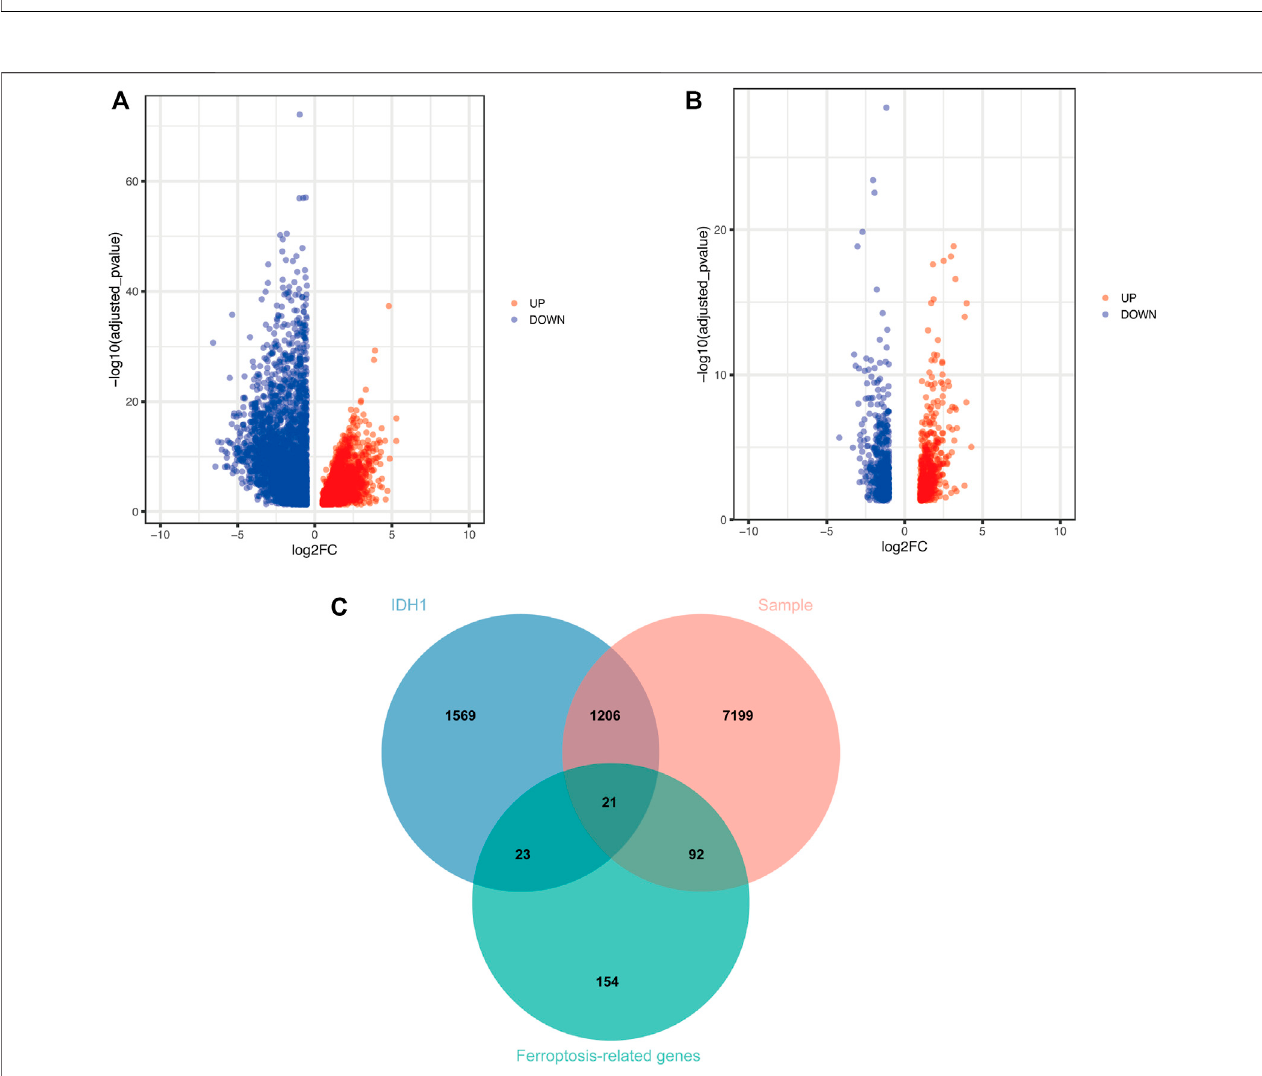
FIGURE 2 | Screening of DEGs (A) Volcano plot demonstrates DEGs of GBM vs. normal brain tissue (B) Volcano plot shows DEGs of IDH1 wild type vs. mutant type (C) Wayne plot indicates shared DEGs.